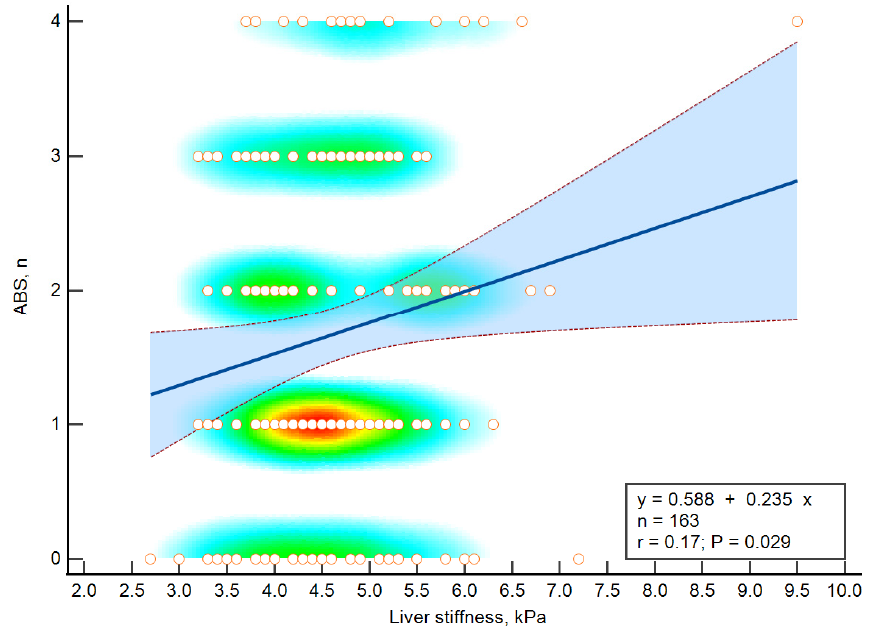
Figure 3. Relationships of liver stiffness and ABS. The blue line represents the regression line, the dashed lines represent the 95% confidence interval. The heatmap reflects the density of observations. Patients with generalized atherosclerosis (ABS = 4) had statistically significantly higher liver stiffness values (see Figure 4).